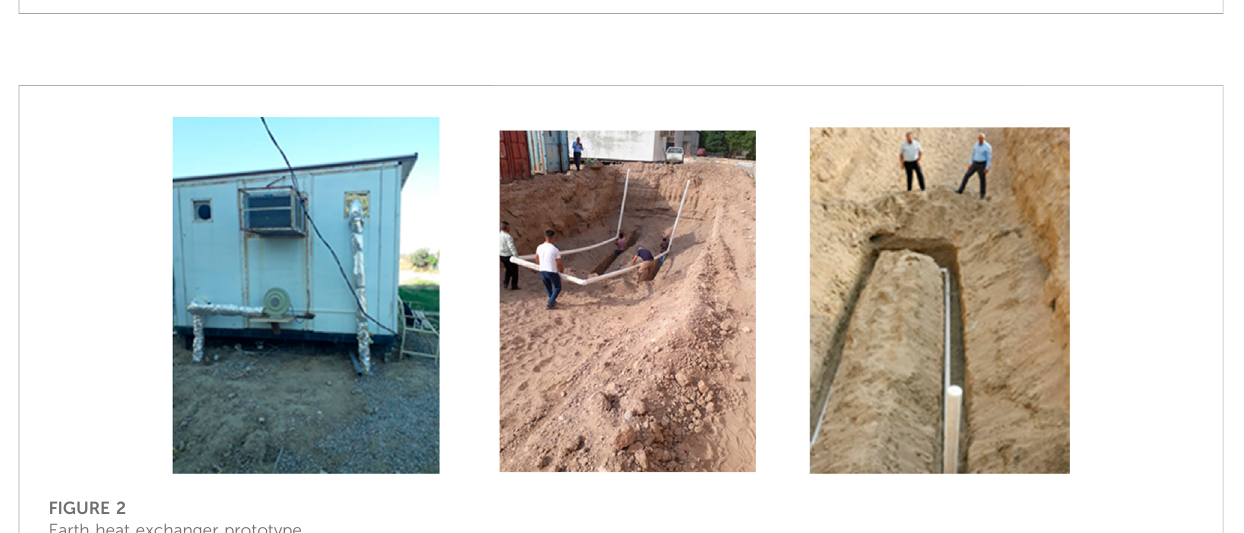
FIGURE 2 Earth heat exchanger